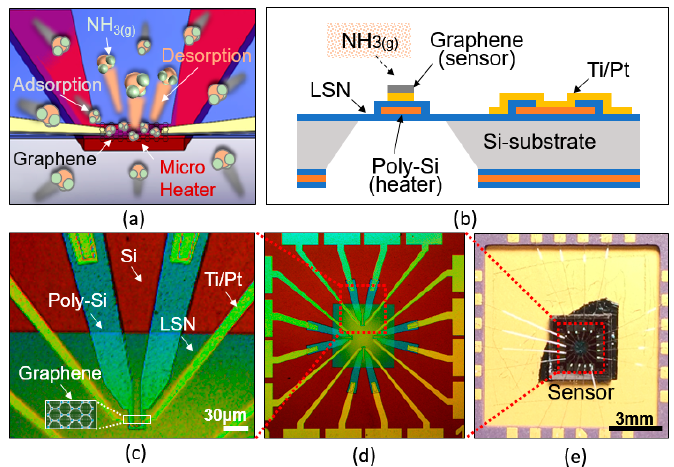
Figure 1. Schematic view of the sensor. ( a ) Concept of a microheater-based graphene gas sensor. Molecules are adsorbed on the graphene and fast recovery is achieved via heat-assisted desorbtion. ( b ) Cross-sectional view of the sensor. Heater is suspended in air to reduce heat loss. ( c ) The graphene is patterned on the bridge of the heater that generates high temperature due to narrow carrier pathway. ( d ) Top view of the device consists of four sensors on a single device. ( e ) A device is connected to a silicon-package by wirebonding. LSN: low-stress silicon-rich nitride.